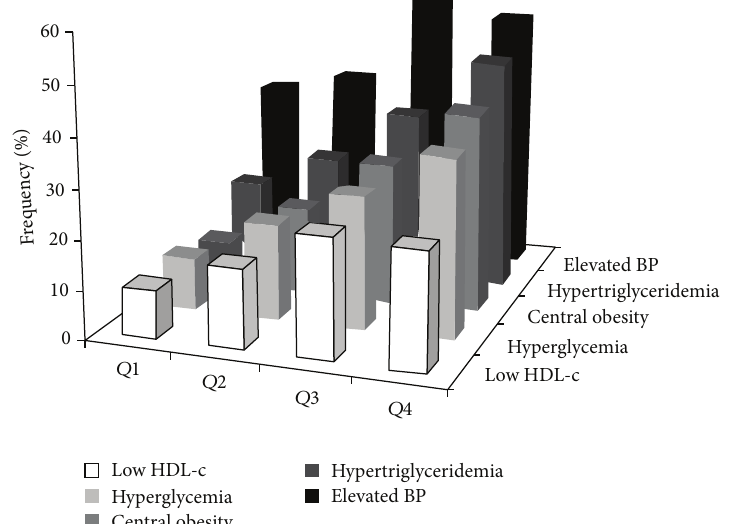
Figure 1: The frequency of each MetS component plotted according to baseline fractalkine quartiles at year